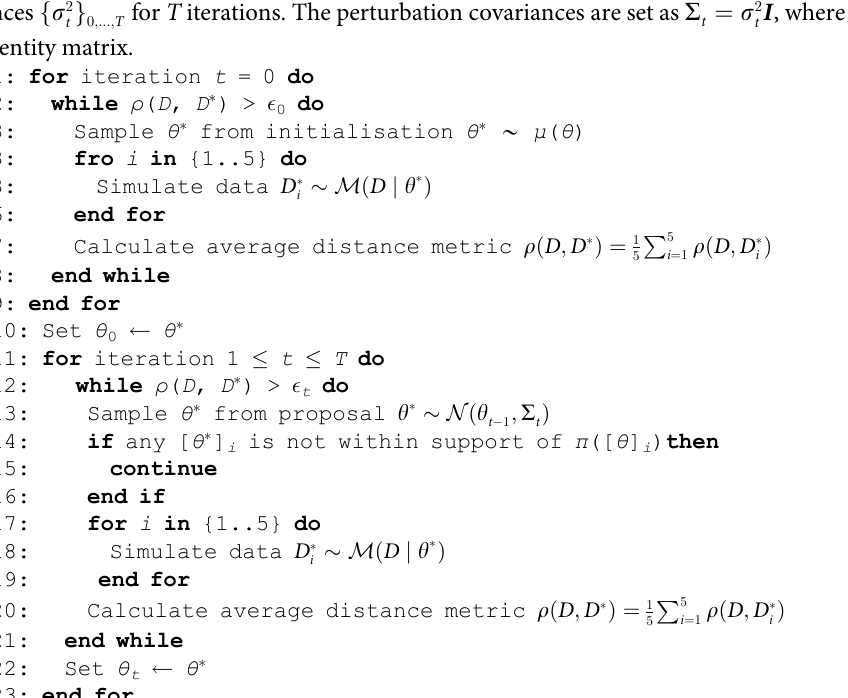
Algorithm 1 Metropolis-Hastings ABC Algorithm for obtaining a point estimate from a mode of the posterior distribution in the parameter space given the initialisation distribution μ ( θ